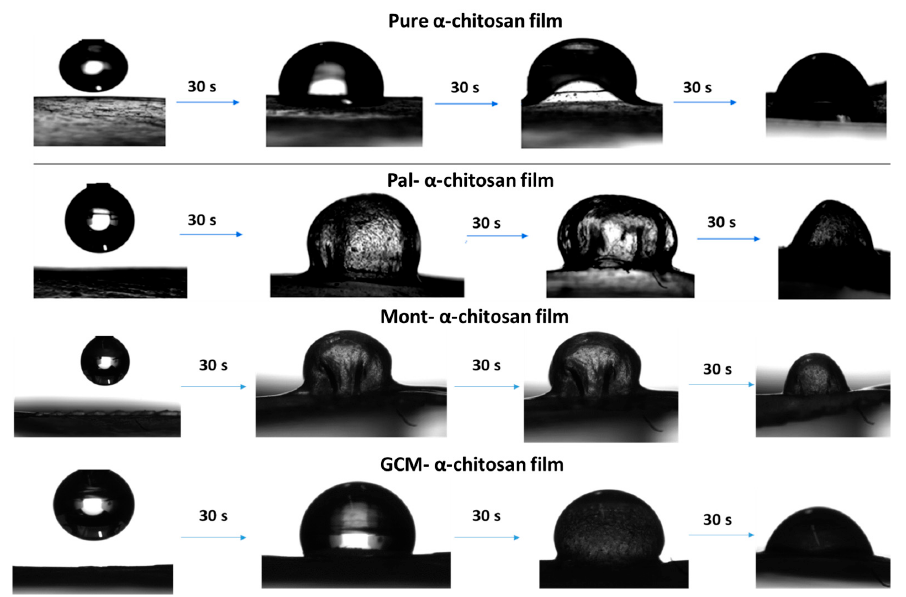
Figure 6. Typical micrographs showing instantaneous changes in droplet shape, and the local swelling of the pure chitosan and the composite